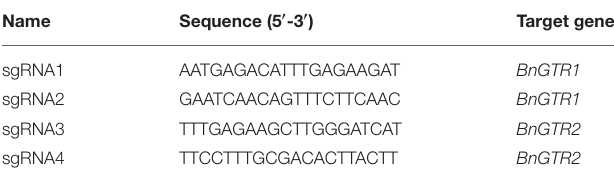
TABLE 9 | CRISPR target sequences